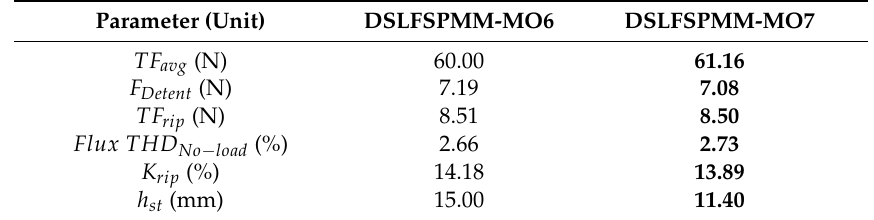
Table 13. Modified parameter and performance comparison of DSLFSPMM-MO6 with DSLFSPMM-MO7.